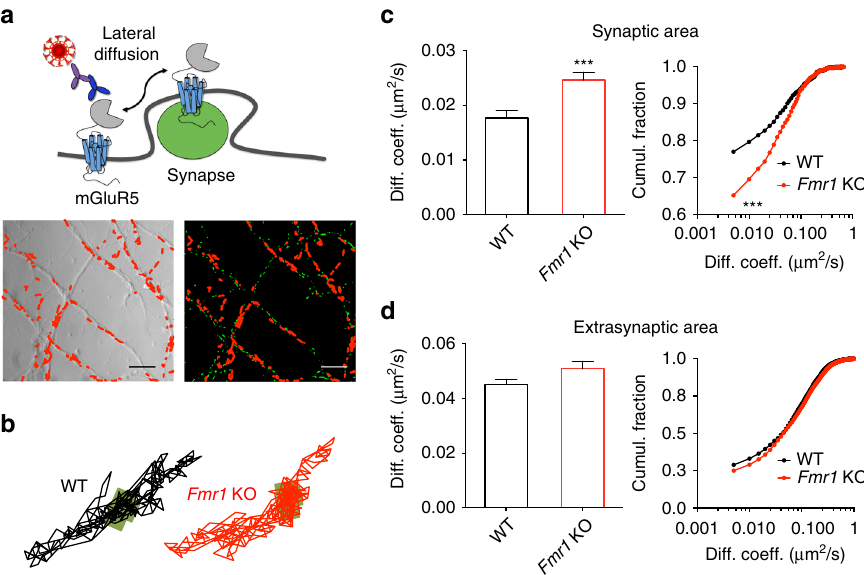
Fig. 1 Cell-surface mGluR5 displays an increased lateral diffusion rate within the synaptic compartment of hippocampal Fmr1 KO neurons. ( a ) Experimental setup. Upper panel: schematic representation of endogenous mGluR5 in the dendritic membrane labeled with a QD-antibody complex targeting the extracellular domain of the receptor. Lower panel: representative images of the dendrites of hippocampal neurons shown in phase contrast (left), and their MitoTracker-labeled synaptic sites (right; green) overlaid with reconstructed trajectories of surface mGluR5-QD complexes (depicted in red) in the dendritic membrane of the same neurons. Scale bar = 5 μ m. ( b ) Representative trajectories of single surface mGluR5-QD in WT and Fmr1 KO neurons. The synaptic sites are represented by the green areas. Scale bar = 1 μ m. ( c ) Cumulative distribution (left panel) and cumulative frequency distribution (right panel) of the instantaneous diffusion coef fi cient of mGluR5-QDs in the synaptic compartment. The lateral diffusion is signi fi cantly higher in Fmr1 KO neurons (WT, 0.017 ± 0.001 µ m 2 /s, n = 1632 trajectories from 16 dendritic fi elds of 3 different cultures); Fmr1 KO, 0.024 ± 0.001 µ m 2 /s, n = 1451 trajectories (14 dendritic fi elds from 3 cultures); ***P < 0.001 by Mann – Whitney test on cumulative distribution; ***P < 0.001 by Kolmogorov – Smirnov test on cumulative frequency distribution). ( d ) Cumulative distribution (left panel) and cumulative frequency distribution (right panel) of the instantaneous diffusion coef fi cient of mGluR5-QDs in the extrasynaptic area of WT and Fmr1 KO neurons (WT, 0.045 ± 0.002 µ m 2 /s, n = 1907 trajectories from 16 dendritic fi elds of 3 different cultures; Fmr1 KO, 0.048 ± 0.002 µ m 2 /s, n = 1347 trajectories from 14 dendritic fi elds of 3 different cultures; P = 0.106